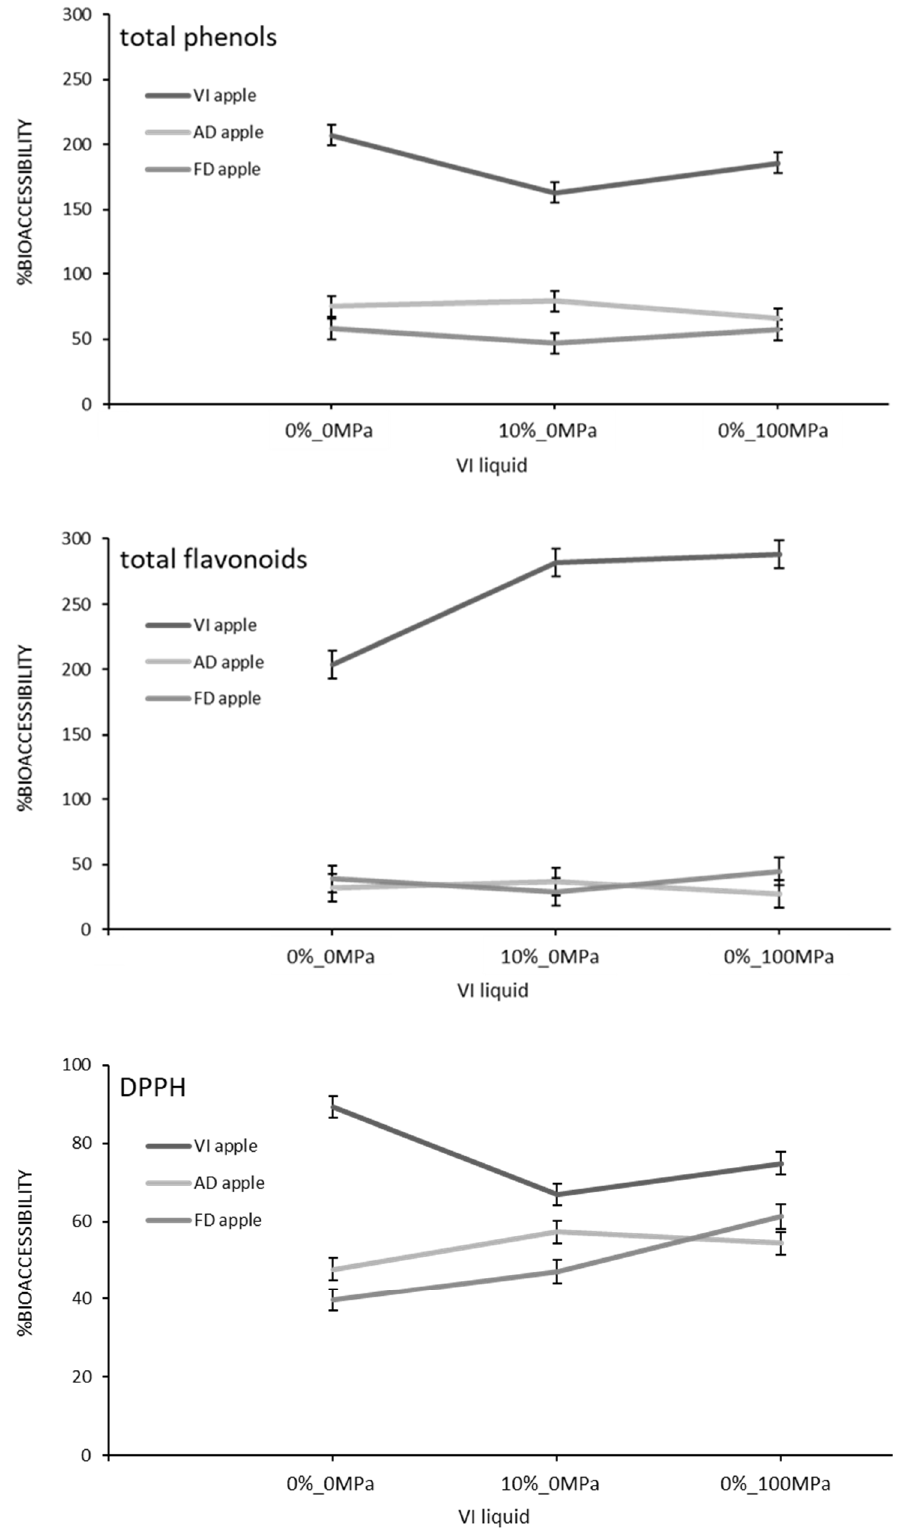
Figure 3. The bioaccessibility of antioxidants as affected by the food matrix (VI, AD, and FD apples) and the vacuum impregnation liquid (0%_0 MPa, 10%_0 MPa, and 0%_100 MPa). Mean values and LSD intervals with a 95% confident level.